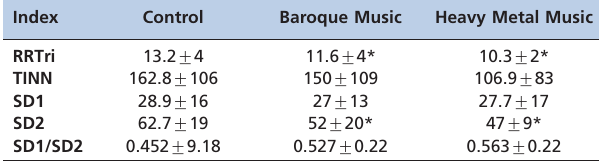
Table 2 - Average values followed by their standard deviations for analysis of geometric indices of HRV.